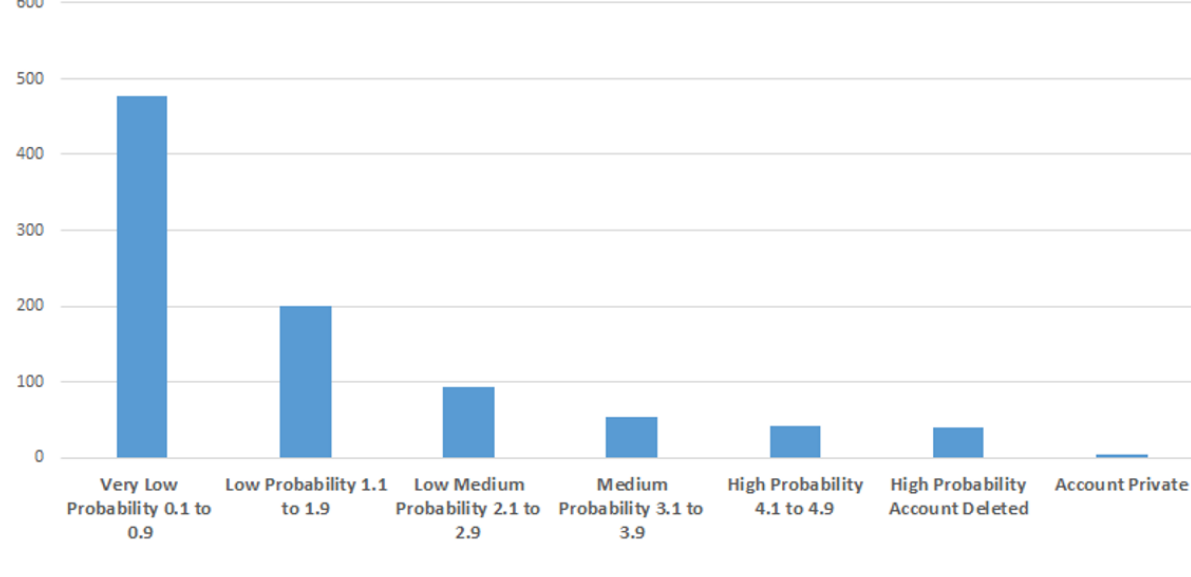
Table 5. Top 5 most frequently used keywords in bios of users who scored 4 or over and whose account was deleted.